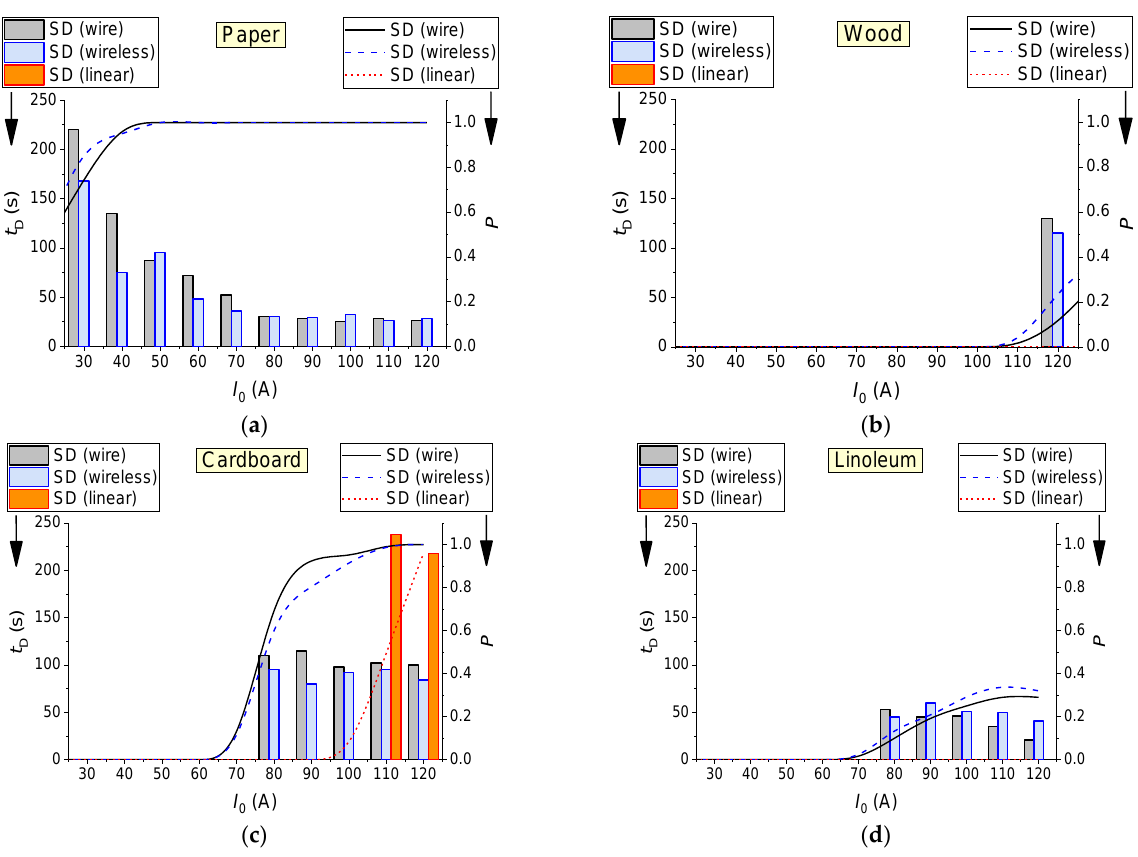
Figure 10. Delay times and frequency of SD activation at different short-circuit current values using model fires composed of paper ( a ), wood ( b ), cardboard ( c ) and linoleum ( d ): SD (wireless) is a wireless smoke detector; SD (wire) is a smoke detector connected in the circuit; SD (linear) is a linear smoke detector.